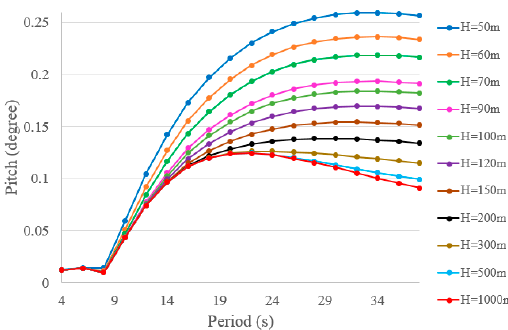
Figure 1. Influence of water depth on the motion of a floating wind turbine [14].